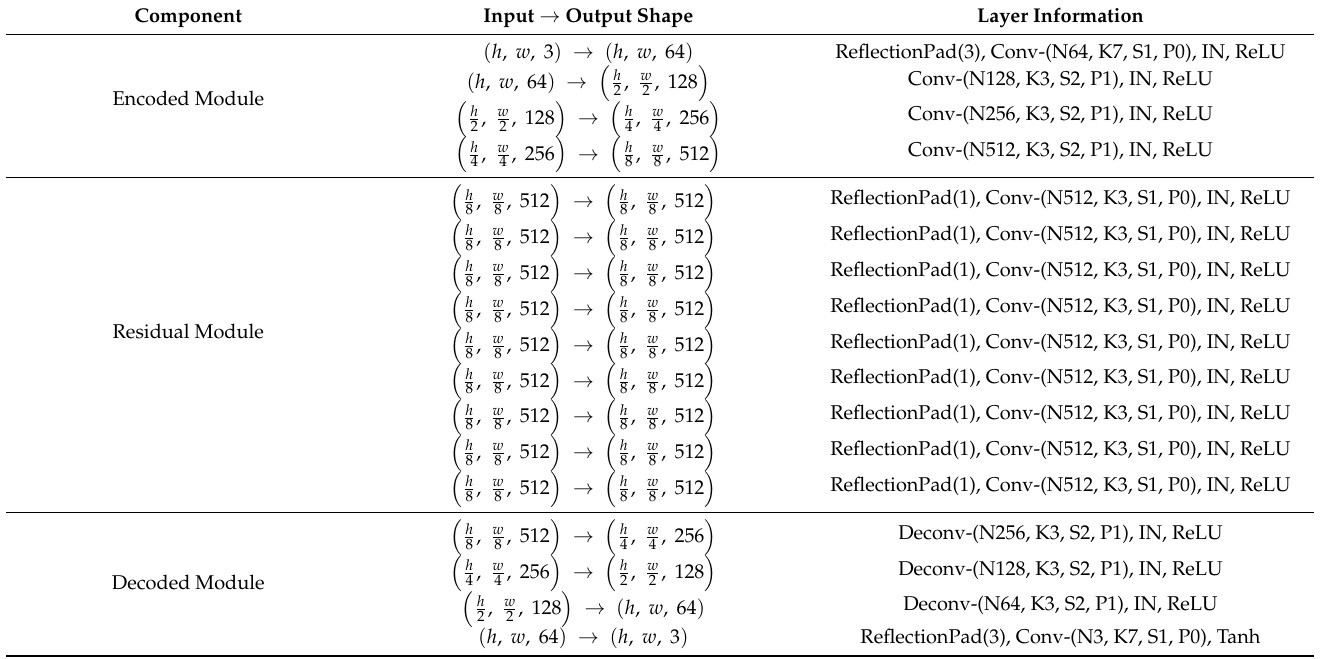
Table 1. Generator network